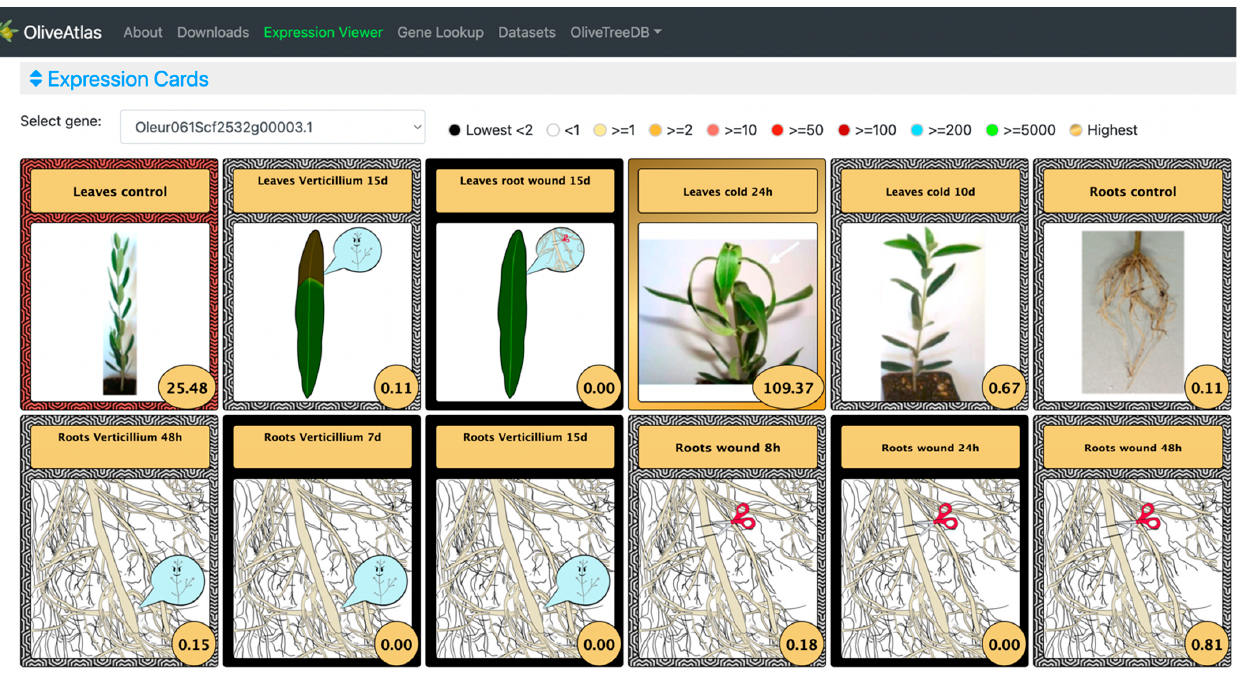
Figure 5. Expression cards in the “Expression viewer” of OliveAtlas. The cards show different colors for different expression value ranges defined in the legend. The highest and lowest values are high- lighted in a golden or black card respectively. The sample Roots wound 7d , with expression value 0, was not included for better visualization.